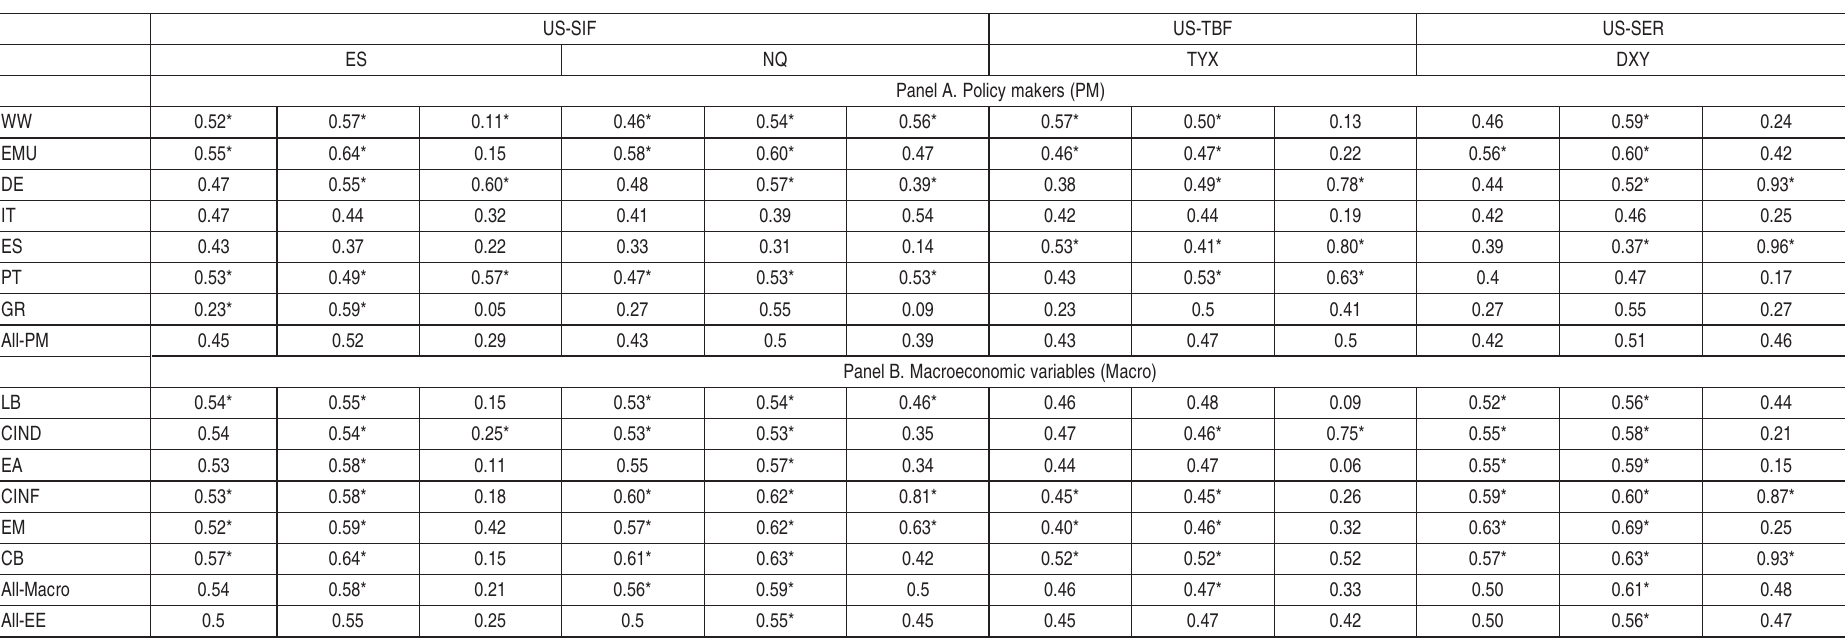
Table 4. Sharpe ratio criterion - US stock index futures (US-SIF), US Treasury bond futures (US-TBF) and US spot exchange rates (US-SER) markets US-SIF US-TBF US-SER